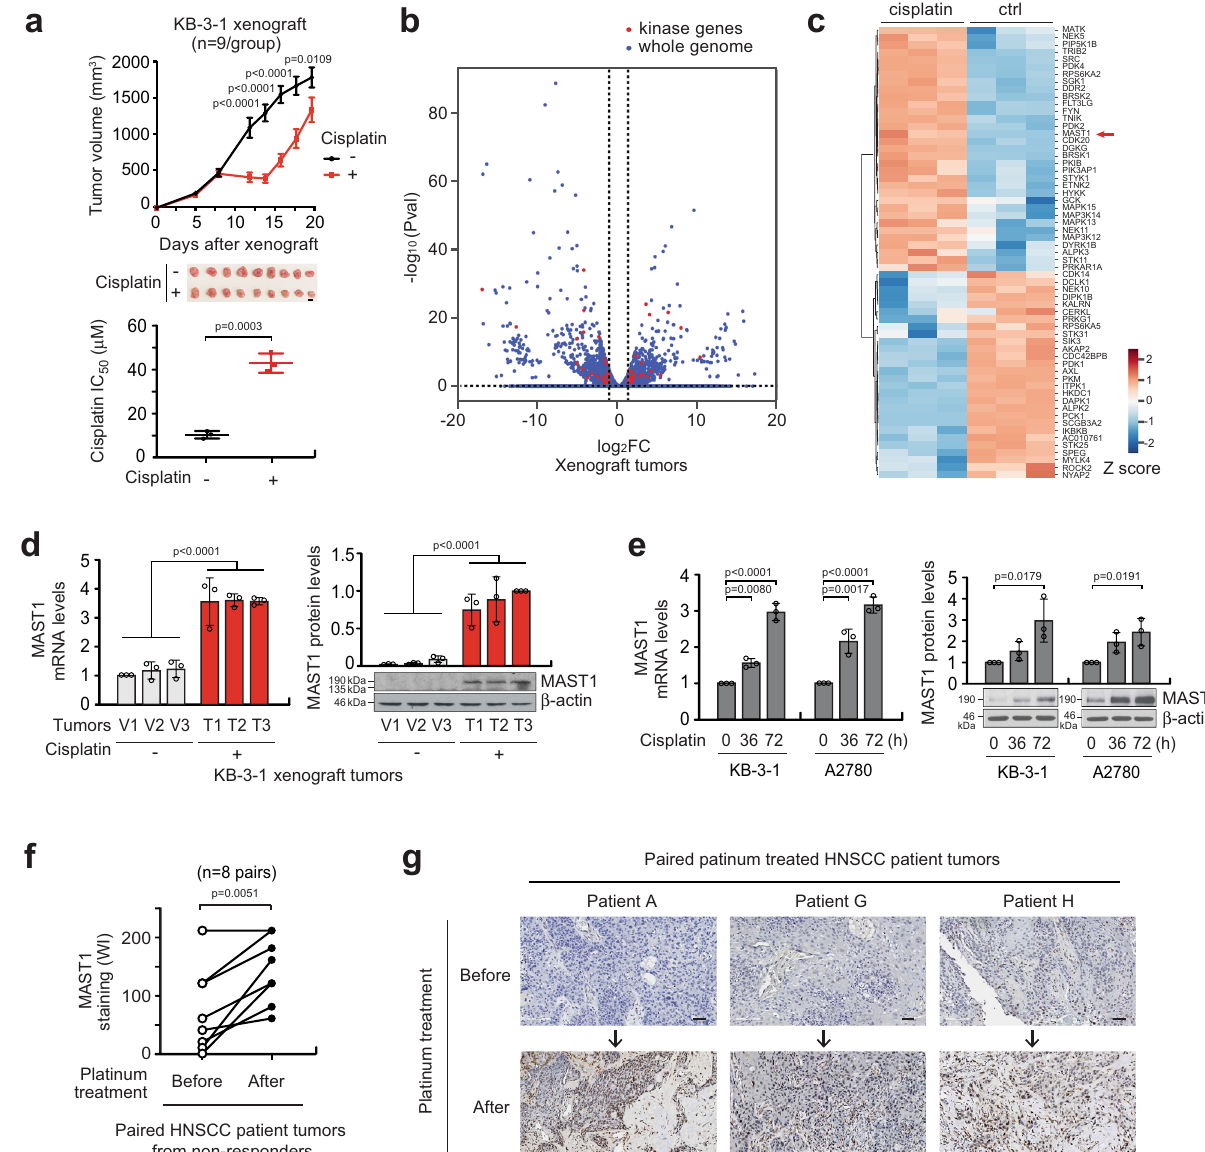
Fig. 1 Cisplatin treatment induces MAST1 in preclinical and clinical patient tumors. a Development of cisplatin-resistant model in vivo. KB-3-1 xenograft mice were treated with 2 doses of cisplatin (0.5 and 5 mg/kg/i.p. on day 5 and 10). Tumor volumes (top) and cisplatin resistance of three representative xenograft tumors was determined by cisplatin IC 50 at the experimental endpoint (bottom). b Transcriptomic analysis of xenograft tumors collected from mice treated with PBS or cisplatin. RNA-sequencing data are presented as a volcano plot and kinase genes are highlighted in red. c A heatmap and hierarchical clustering analysis summarizing expression pro fi le of kinase genes with a fold change greater than 1.2. MAST1 is highlighted with an arrow. d Quantitative RT-PCR and western blot results show increased MAST1 expression in KB-3-1 xenograft mice tumors collected from the cisplatin-treated group (T1 – T3) compared to the vehicle-treated group (V1 – V3). Three representative tumors from each group were randomly selected for analyses. e The mRNA and protein levels of MAST1 in KB-3-1 and A2780 cells treated with cisplatin (0.5 μ g/ml) for the indicated times were determined as d . f IHC staining scores of MAST1 in paired primary head and neck squamous cell carcinoma (HSNCC) patient tumors obtained before and after platinum therapy. Patients were considered non-responders to platinum treatment when disease recurred within 2 years after chemotherapy. Weighted index (WI) = positive staining (%) x intensity score (0 – 3 + ). g Representative images of f are shown. Scale bars represent 10 mm for a and 50 μ m for g . Data are mean ± SEM for tumor volume in a upper panel ( n = 9 mice/group) and mean ± SD for cisplatin IC 50 in a lower panel ( n = 3 randomly selected tumors/group). For d and e , data are mean ± SD from three independent biological experiments. Statistical analyses were performed by two-way ANOVA for tumor volume and unpaired two-tailed t -test for IC 50 in a and d , one-way ANOVA for e , and paired two-tailed t -test for f . Source data are provided as a Source Data fi